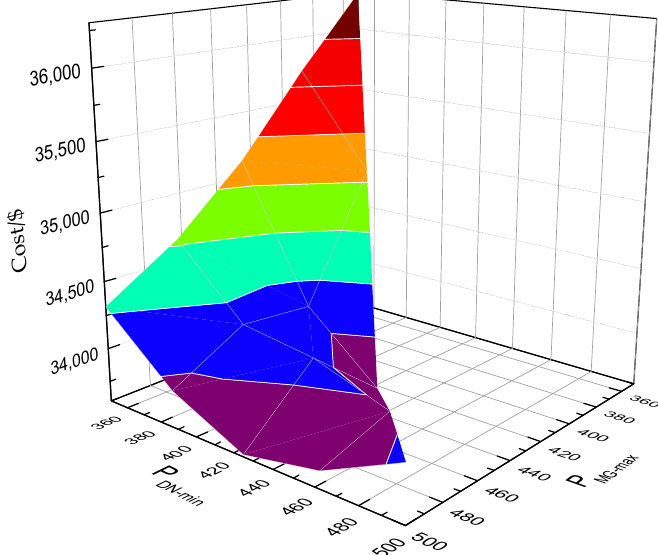
Figure 10. System cost change trend under different capacity upper and lower limits.